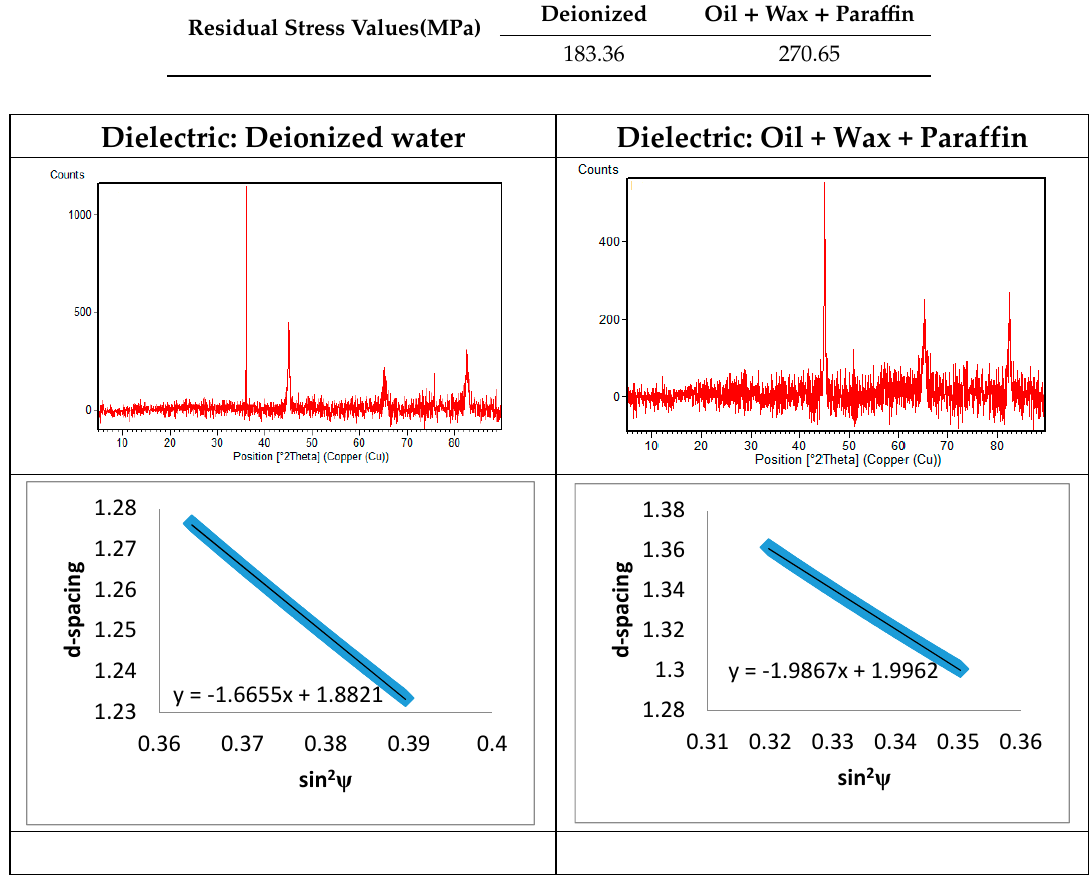
Figure 12. XRD plot and residual stress analysis of wire electrical discharge machined Al-SiC-TiC metal matrix composite surface.